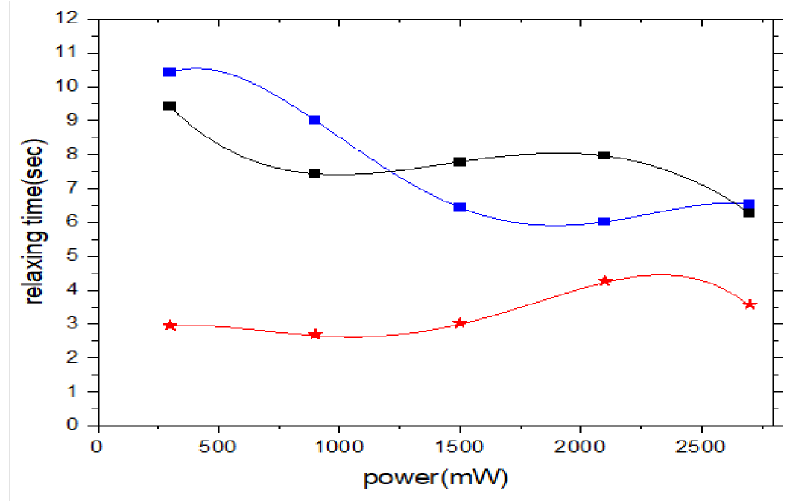
Figure 7. Relaxation time constant as a function of the power for the untreated (red), 3 h treated (blue), and 6 h treated